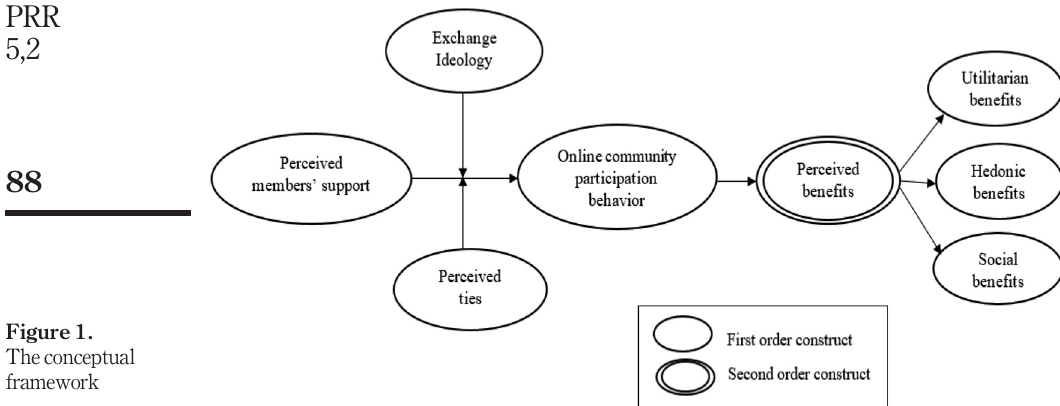
Figure 1. The conceptual